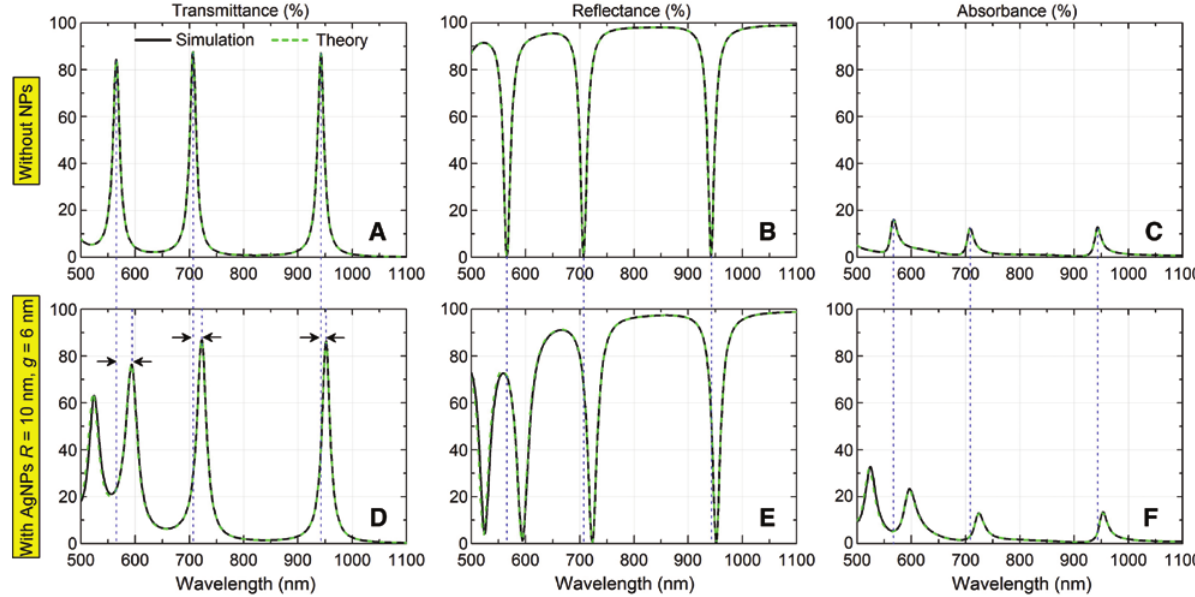
Figure 3: Study of optical properties of the proposed device. (A and D) Transmittance, (B and E) reflectance, and (C and F) absorbance spectra from a Fabry–Perot interferometer with water-filled cavity of 1 μ m length formed between two thin Ag films (20 nm thickness), without (A)–(C) and with (D)–(F) a 2D NP array of Ag nanospheres of radius R = 10 nm and inter-NP gap g = 6 nm on each of those films. Curves: black solid, full-wave simulation; green dashed, effective medium